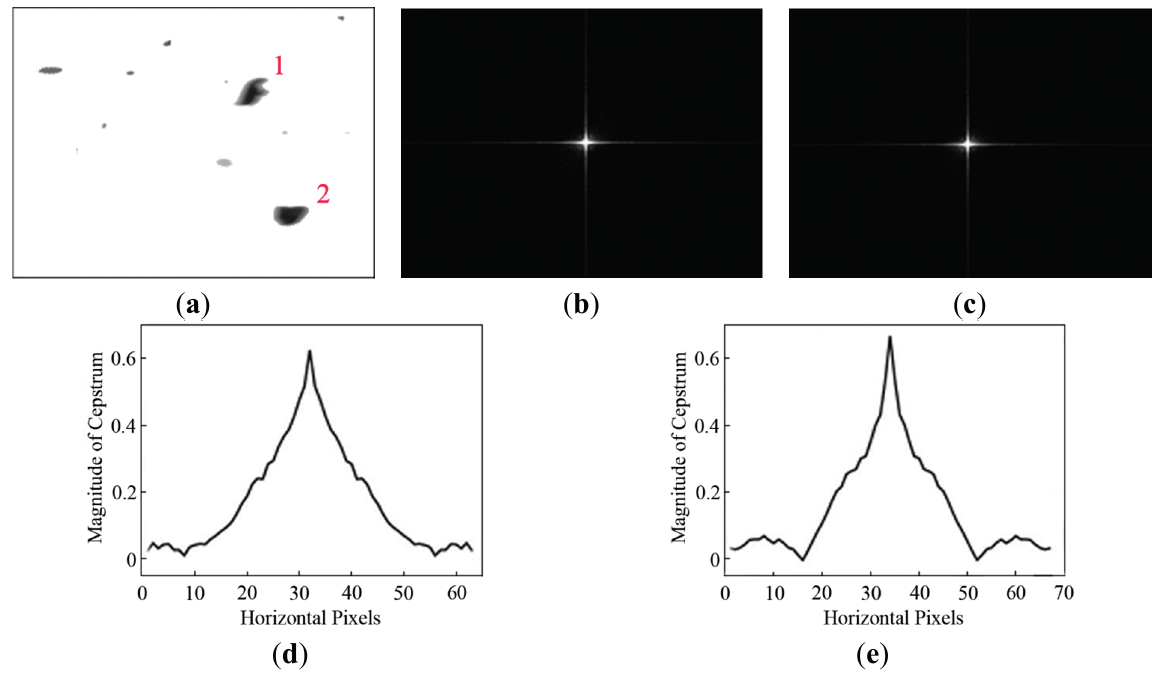
Figure 8. Estimated PSF of particles #1 and #2: ( a ) segmented debris image; ( b ) power cepstrum of the particle #1 with θ 1 = 0°; ( c ) power cepstrum of the particle #2 with θ 2 = 0°; ( d ) cepstrum magnitude of the particle #1 with L 1 = 23 pixels; and ( e ) cepstrum magnitude of the particle #2 with L 2 = 18 pixels.